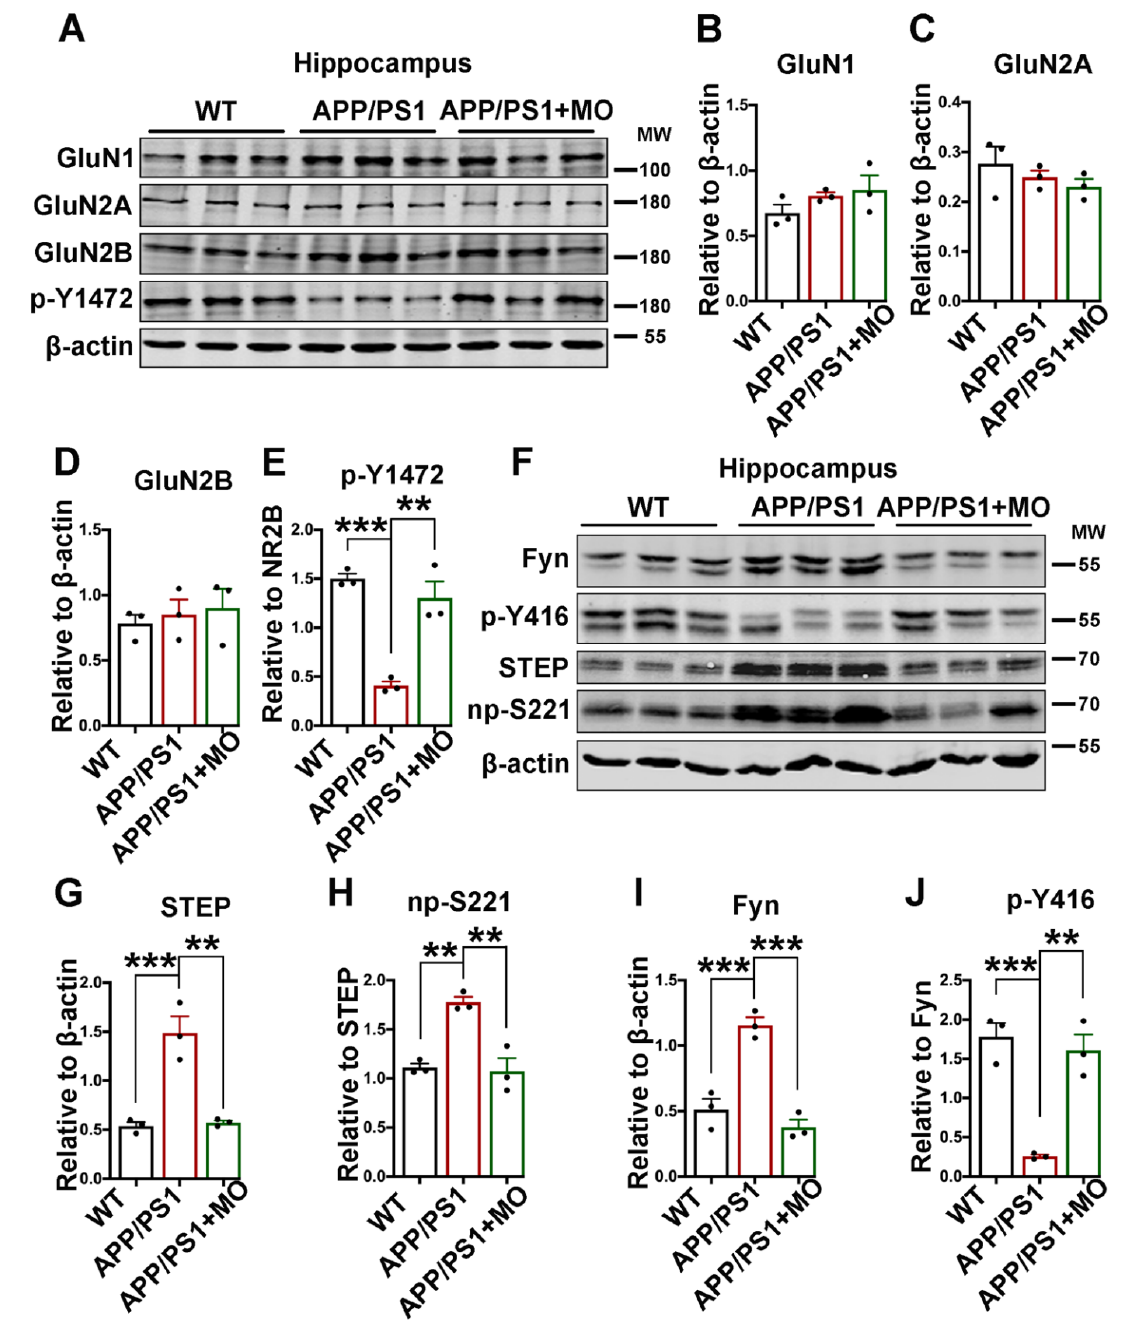
Figure 4. MO improves GluN2B phosphorylation by decreasing STEP in APP/PS1 mice. ( A ) The expression level of GluN1, GluN2A, GluN2B, and p-Y1472 from hippocampal lysates of WT and APP/PS1 mice with or without MO treatment was evaluated by Western blotting. ( B – E ) The sta- tistical analysis of Western blot bands from panel A. ( F ) The expression level of STEP, np-S221, Fyn, and p-Y416 from hippocampal lysates of WT control and APP/PS1 mice with or without MO treatment was examined. ( G – J ) The statistical analysis of Western blot bands from panel F. β -actin serves as the loading control. The data are presented as Mean ± SEM, ( n = 3). ** p < 0.01 and *** p < 0.001 vs. WT or vs. APP/PS1 mice groups. p-Y1472 = phosphorylated GluN2B at Tyr1472; np-S221 = non-phosphorylated STEP at Ser221; p-Y416 = phosphorylated Fyn at